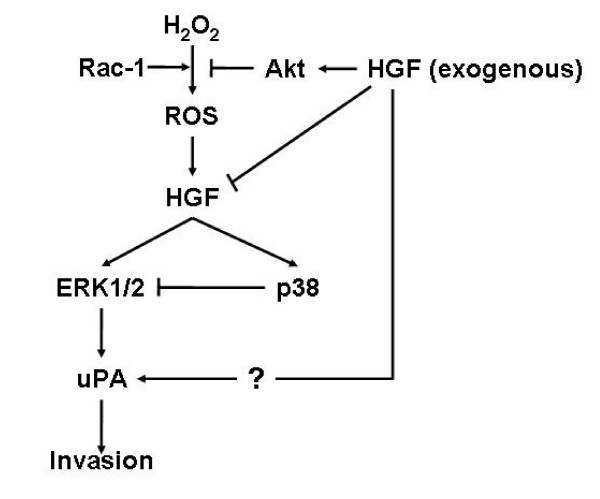
Interaction of exogenous HGF with H2O2 in uPA expression.